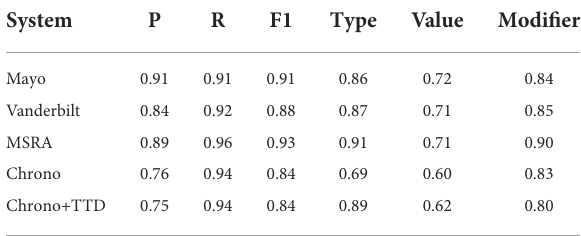
TABLE 6 End-2-End results for state-of-the-art systems, Chrono, and Chrono+TTD (ClinBioBert-Seq2Seq-Ttype) using span-based P, R, and F1 metrics.